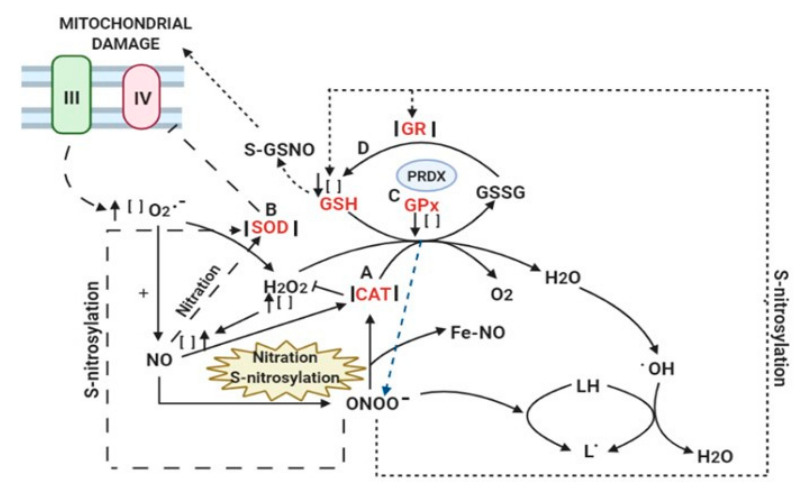
Figure 3. Nitrosative stress and the antioxidant system. A deficient of the antioxidant defense mechanisms favor the processes of nitration and nitrosylation of different enzymes. Reaction (A): Nitration and S-nitrosylation influence the activity of the CAT that affects its binding to H 2 O 2 .